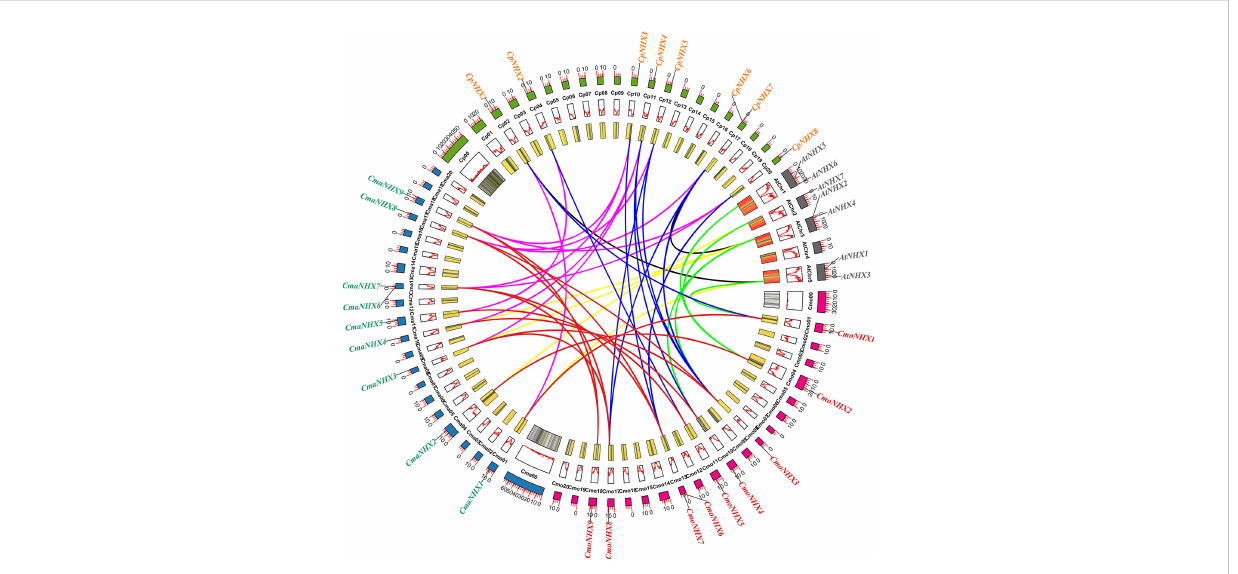
FIGURE 4 Synteny analysis of the NHX genes among C. moschata , C. maxima , C. pepo and A. thaliana . Cmo, C. moschata ; Cma, C. maxima ; Cp, C. pepo ; At, A. thaliana ; The red lines indicated the syntenic NHX gene pairs between C. moschata and C. maxima ; The blue lines indicated the syntenic NHX gene pairs between C. moschata and C. pepo ; The pink lines indicated the syntenic NHX gene pairs between C. maxima and C. pepo ; The green lines indicated the syntenic NHX gene pairs between C. moschata and A. thaliana ; The yellow lines indicated the syntenic NHX gene pairs between C. maxima and A. thaliana ; The black lines indicated the syntenic NHX gene pairs between C. pepo and A. thaliana . All the data for the various species was extracted from Cucurbit genomics